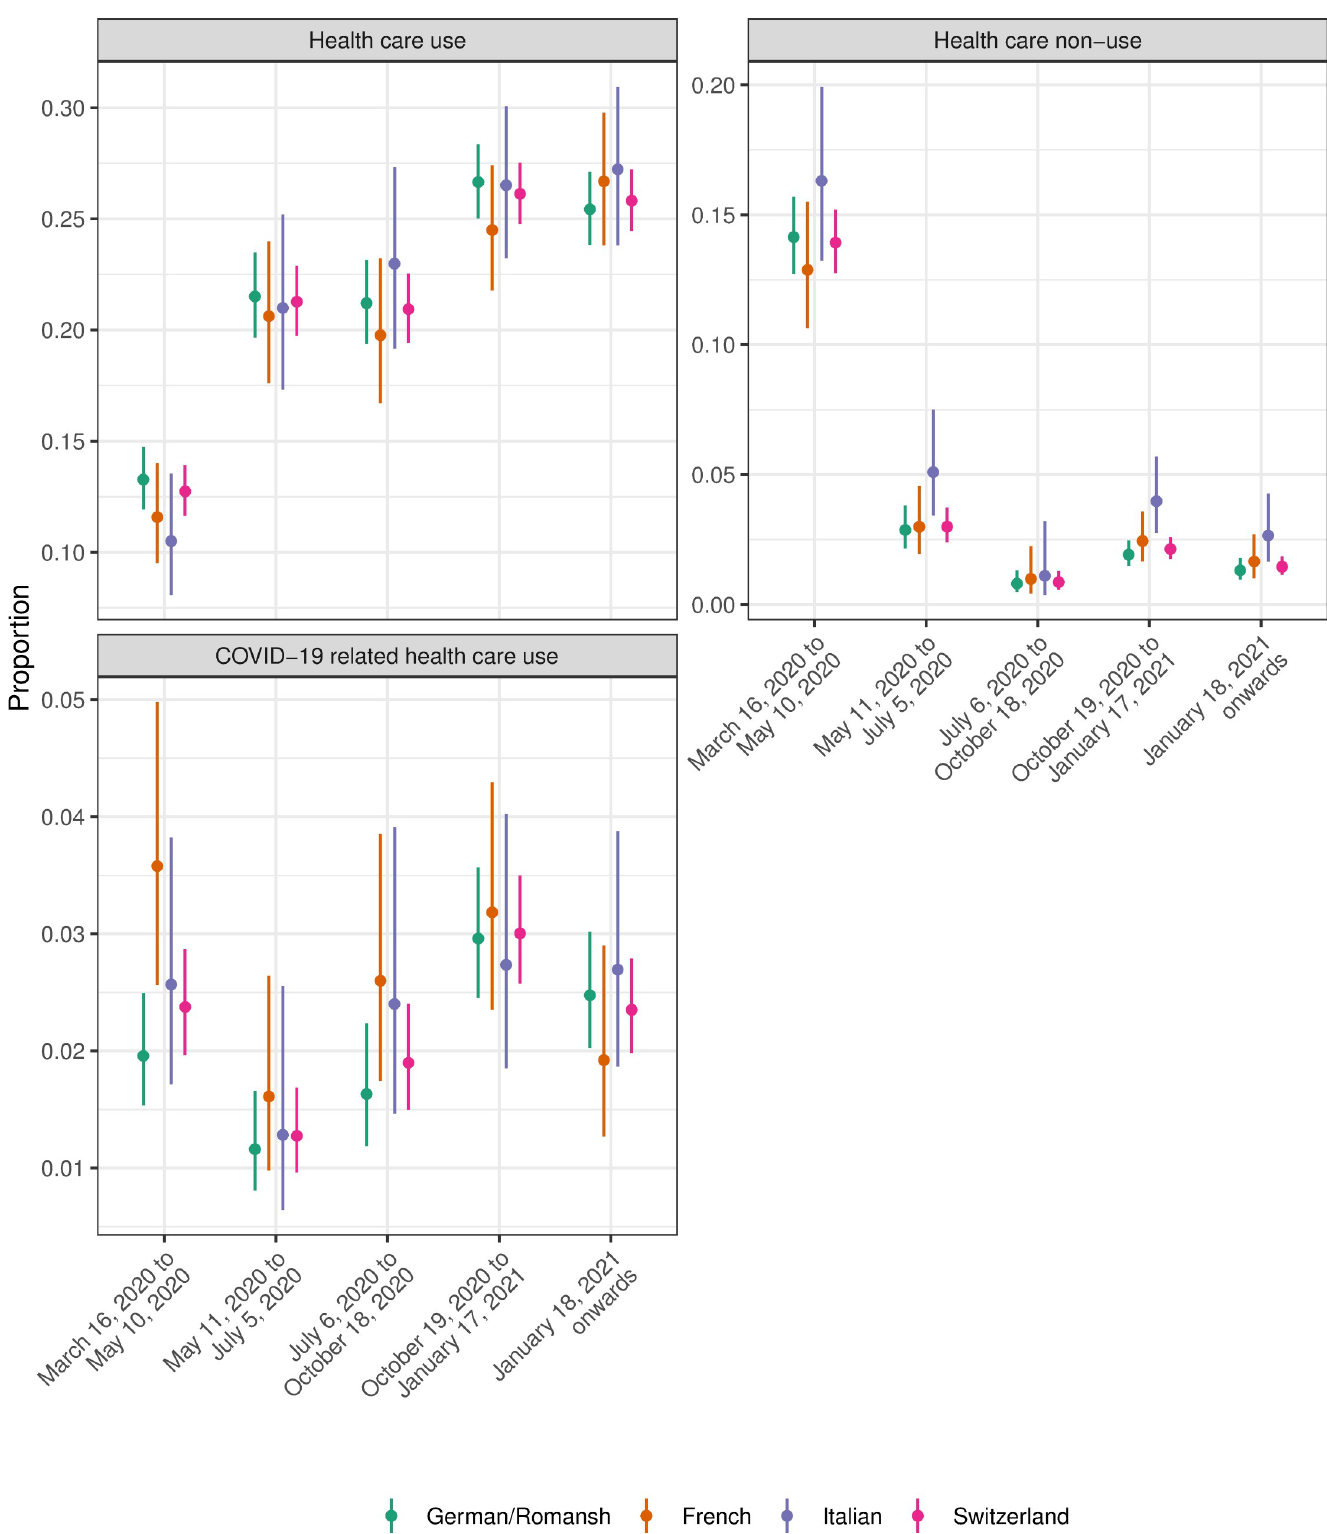
Fig 4. Proportion of study outcomes for the domain of health care use, by mitigation period, language region and for the whole of Switzerland.